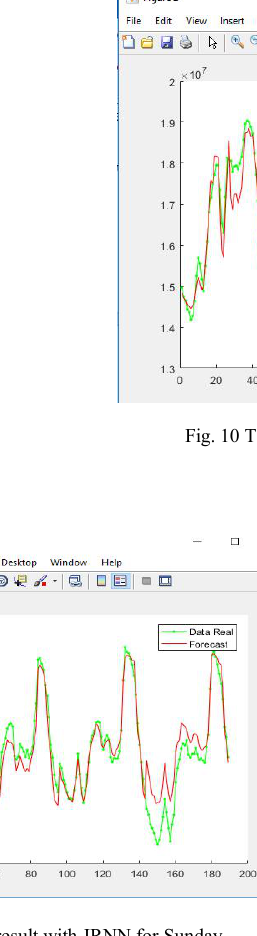
Fig. 11 Test result with JRNN for Sunday